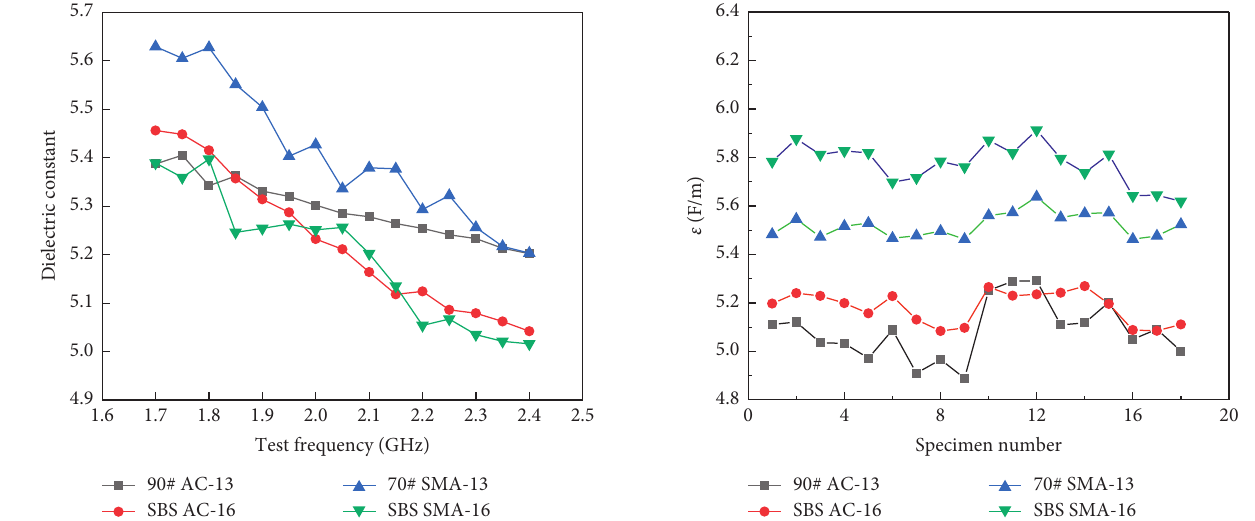
Figure 4: Dielectric constant of the asphalt mixtures.